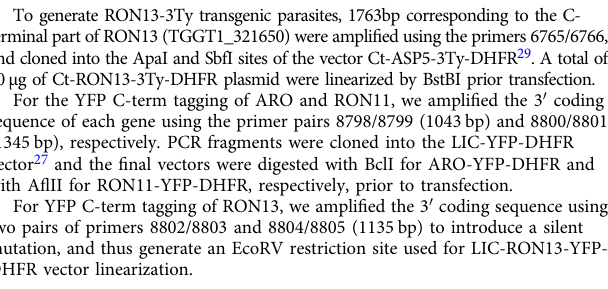
To generate RON13-3Ty transgenic parasites, 1763bp corresponding to the C- terminal part of RON13 (TGGT1_321650) were ampli fi ed using the primers 6765/6766, and cloned into the ApaI and SbfI sites of the vector Ct ‐ ASP5 ‐ 3Ty ‐ DHFR 29 . A total of 40µg of Ct-RON13-3Ty-DHFR plasmid were linearized by BstBI prior transfection. For the YFP C-term tagging of ARO and RON11, we ampli fi ed the 3 ′ coding sequence of each gene using the primer pairs 8798/8799 (1043bp) and 8800/8801 (1345bp), respectively. PCR fragments were cloned into the LIC-YFP-DHFR vector 27 and the fi nal vectors were digested with BclI for ARO-YFP-DHFR and with A fl II for RON11-YFP-DHFR, respectively, prior to transfection. For YFP C-term tagging of RON13, we ampli fi ed the 3 ′ coding sequence using two pairs of primers 8802/8803 and 8804/8805 (1135bp) to introduce a silent mutation, and thus generate an EcoRV restriction site used for LIC-RON13-YFP- DHFR vector linearization.